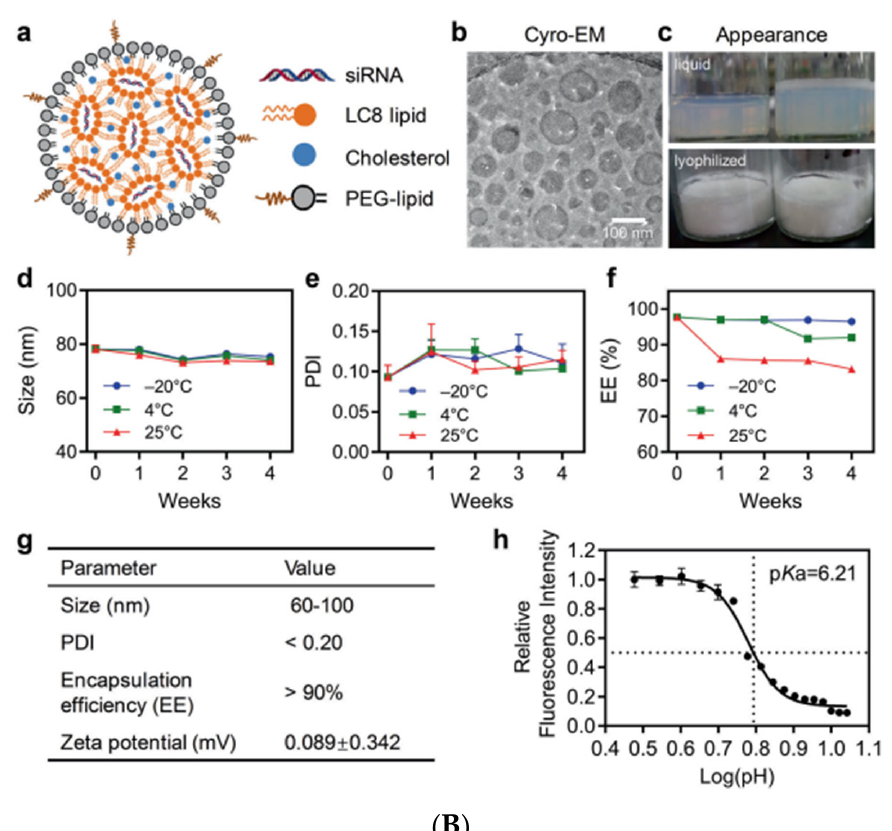
Figure 9. ( A ) : Schematic representation of RBP131/siApoB-mediated gene silencing. The siApoB encapsulated by RBP131 (RBP131/siApoB) was injected IV into C57BL/6 mice. After reaching the target site (liver), the RBP131/siApoB binds to the apoB gene and degrades it reducing the apoB protein levels. ( B ) Characteristics of RBP131/siRNA NPs. ( a ) Graphical representation of RBP131/siRNA NP and its compositions. ( b ) Cryo-EM image of RBP131/siRNA NPs. ( c ) Images displaying liquid and lyophilized forms of RBP131/siRNA formulations. ( d ) Particle size. ( e ) PDI. ( f ) Encapsulation efficiency of RBP131/siRNA kept at varying temperatures for different weeks, respectively. ( g ) Details of RBP131/siRNA formulation properties. ( h ) Graph displaying pKa titration of RBP131/siRNA complex. Adapted from Ref. [175], Signal Transduct. Target. Ther. 2022.